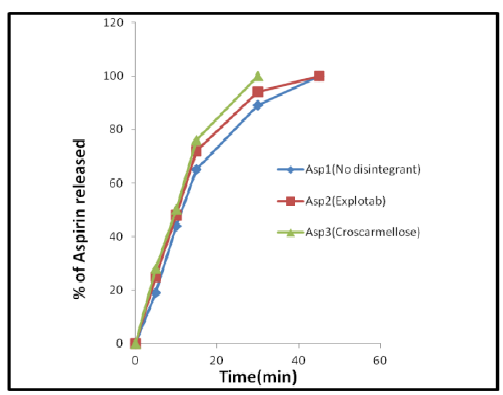
Figure1: The effect of different disintegrants on the dissolution profile of aspirin layer in 0.1N HCl and 37˚C . Evaluation of compressed clopidogrel floating sustained release layer The results of friability, hardness , content uniformity , floating lag time and floating duration are summarized in table(4). Table 4: Evaluation parameters of clopidogrel floating sustained release